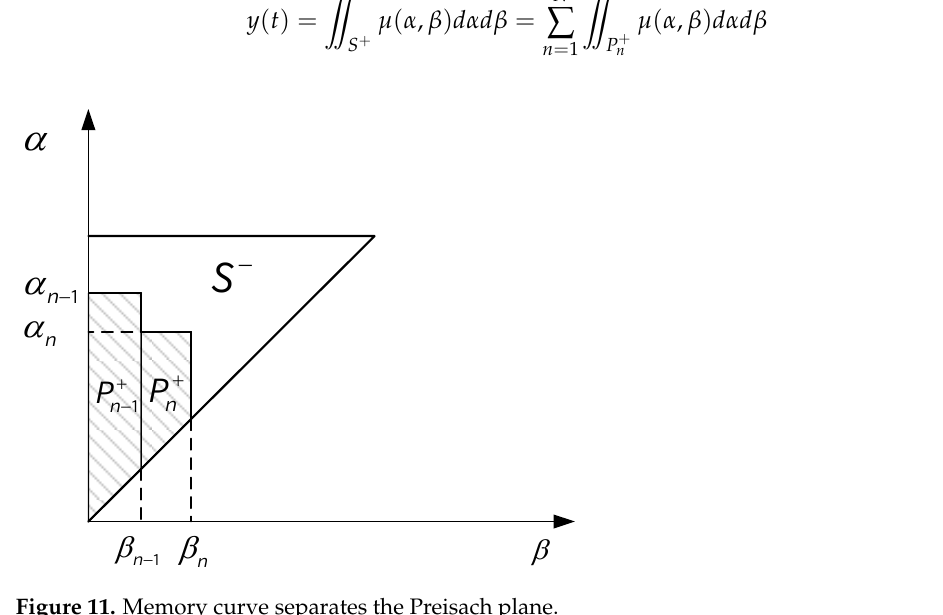
Figure 11. Memory curve separates the Preisach plane.